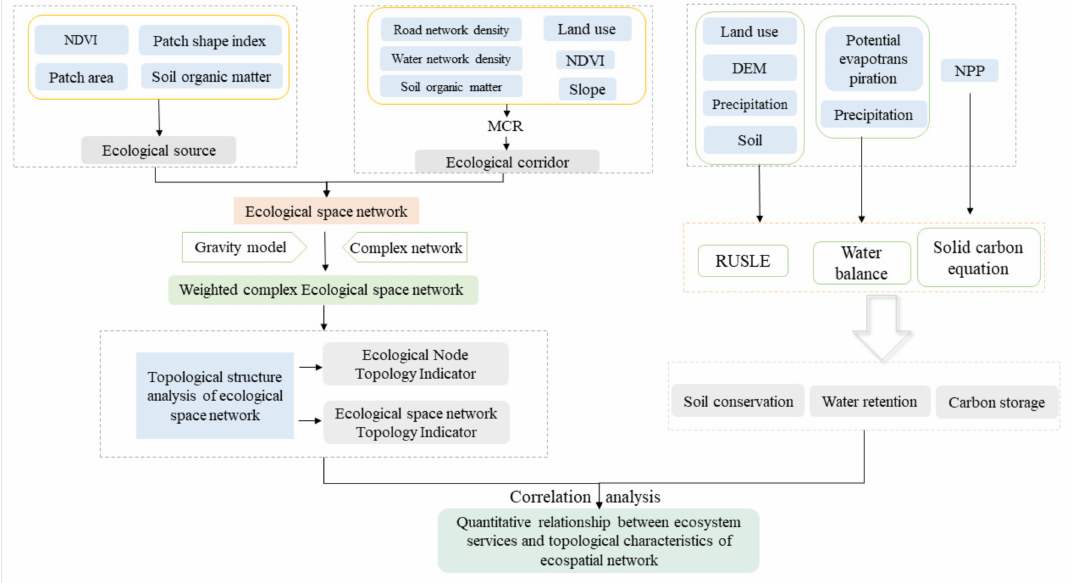
Figure 2. Schematic diagram of the study